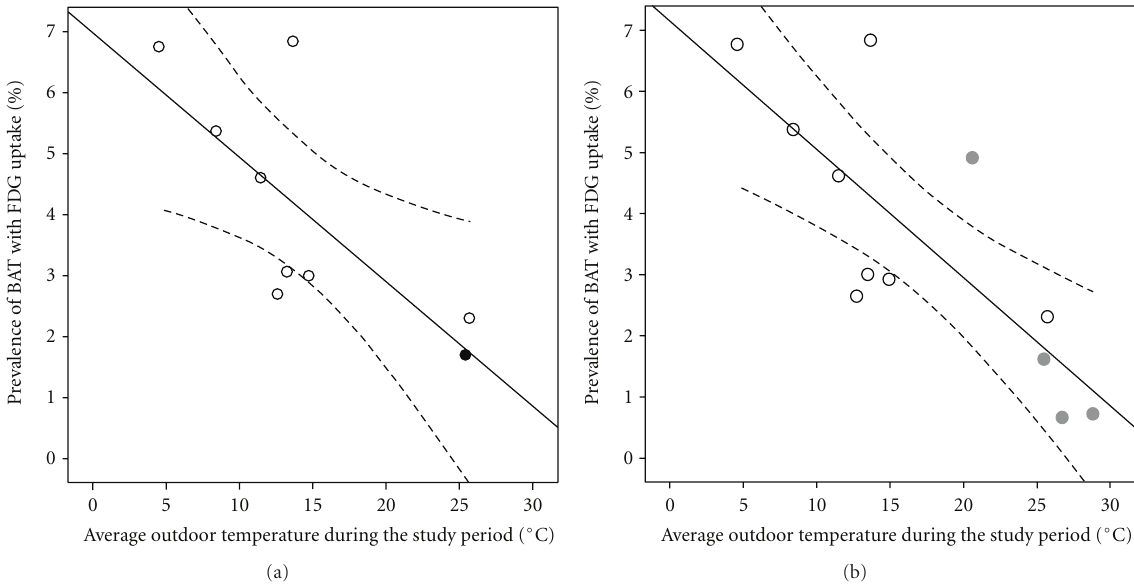
Figure 3: A simple linear regression was done for the review analysis of the association between the prevalence of activated BAT with 18 F- FDG uptake and the average outdoor temperatures during the study period. (a) The prevalence of brown adipose tissue (BAT) in the 8 previous studies [8–15] (white circles) and our patients (black circle), plotted against the average outdoor temperatures during the study period. There was a significant negative correlation ( r = − 0 . 741, slope = − 0.20, P = 0 . 022) between the prevalence of activated BAT on 18 F-FDG PET scans and the average outdoor temperature. (b) The prevalence of BAT in the 8 previous studies (white circles) and our data grouped into 4 seasons (gray circles) plotted against the average outdoor temperature during the study period. The correlation was more significant ( r = − 0 . 792, slope = − 0.21, P = 0 . 002). The solid line is the linear regression line; dashed lines indicate the 95% confidence